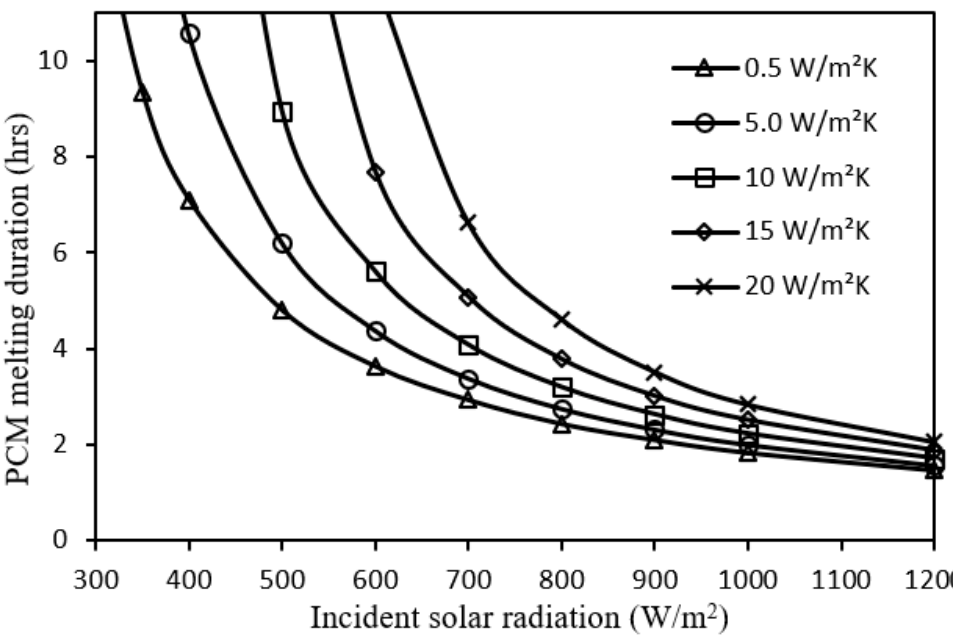
Figure 8. Impact of incident solar radiation on PCM melting duration for different metal foam convective heat transfer coefficients.